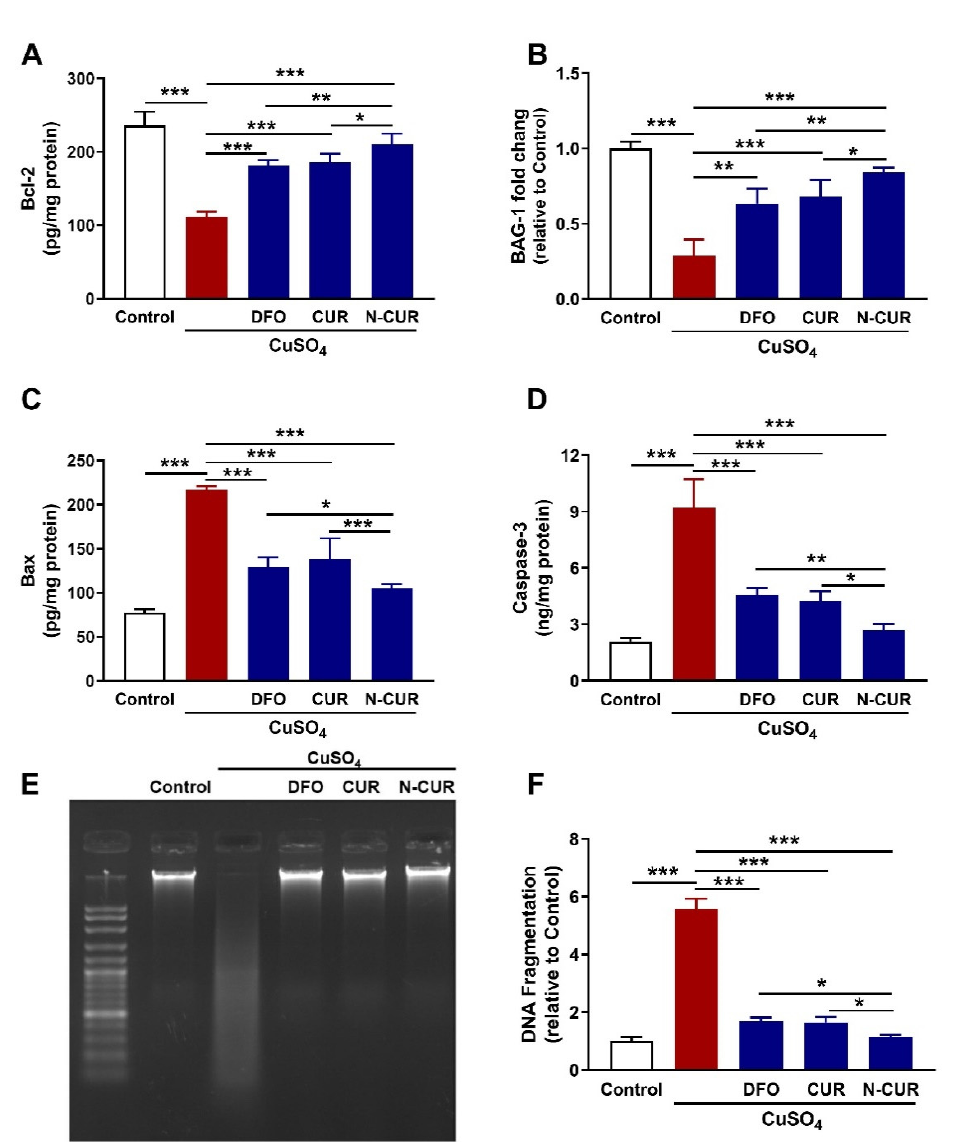
Figure 6. N-CUR and CUR prevent apoptosis in Cu-intoxicated rats. N-CUR, CUR, and DFO in- creased cardiac Bcl-2 ( A ) and BAG-1 mRNA ( B ), decreased Bax ( C ), and caspase-3 ( D ), and prevented DNA fragmentation ( E , F ) in Cu-intoxicated rats. Data are mean ± SD, ( n = 8). * p < 0.05, ** p < 0.01 and *** p < 0.001.